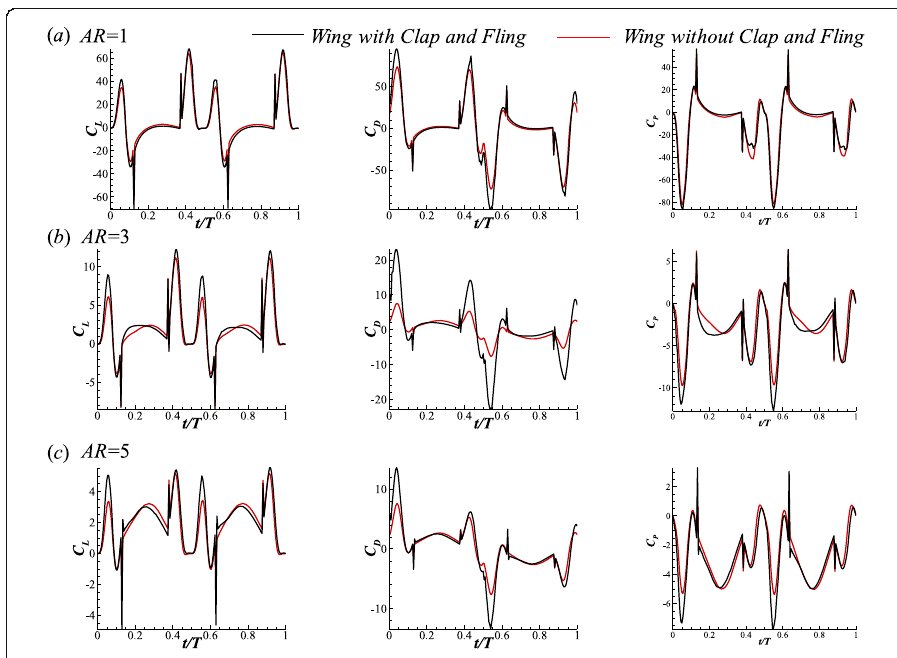
Fig. 9 Instantaneous aerodynamic coefficient and power coefficient under different AR ( a ) AR = 1, ( b ) AR = 3, ( c ) AR =